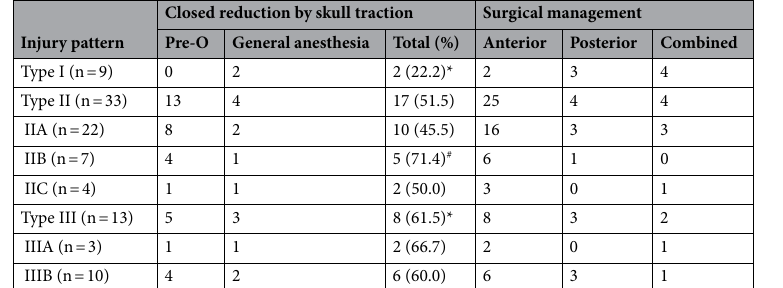
Closed reduction by skull traction Surgical management Injury pattern Pre-O General anesthesia Total (%) Anterior Posterior